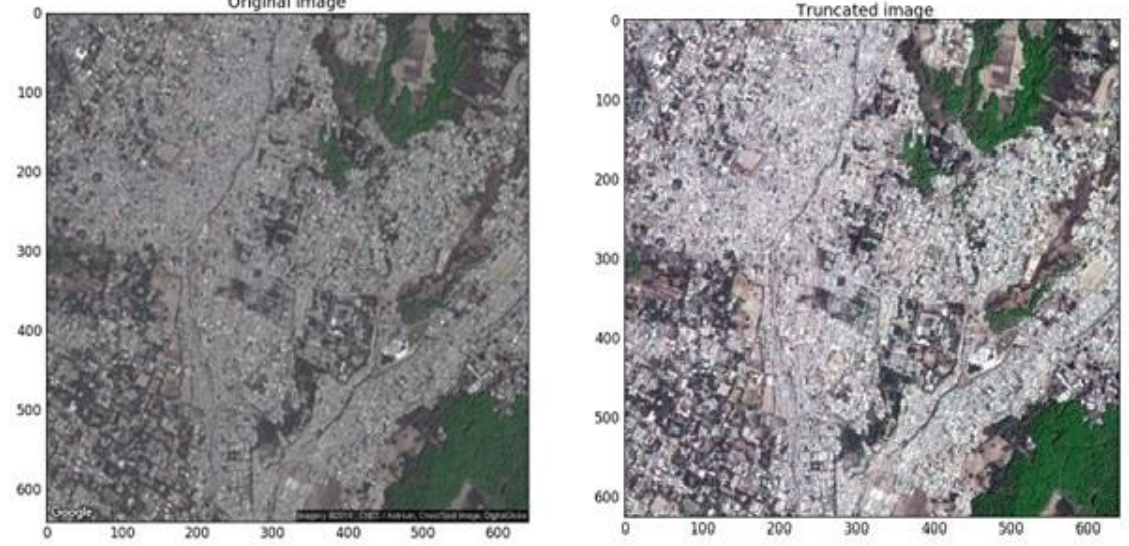
Figure. 3 The original image from the Google server and the image after